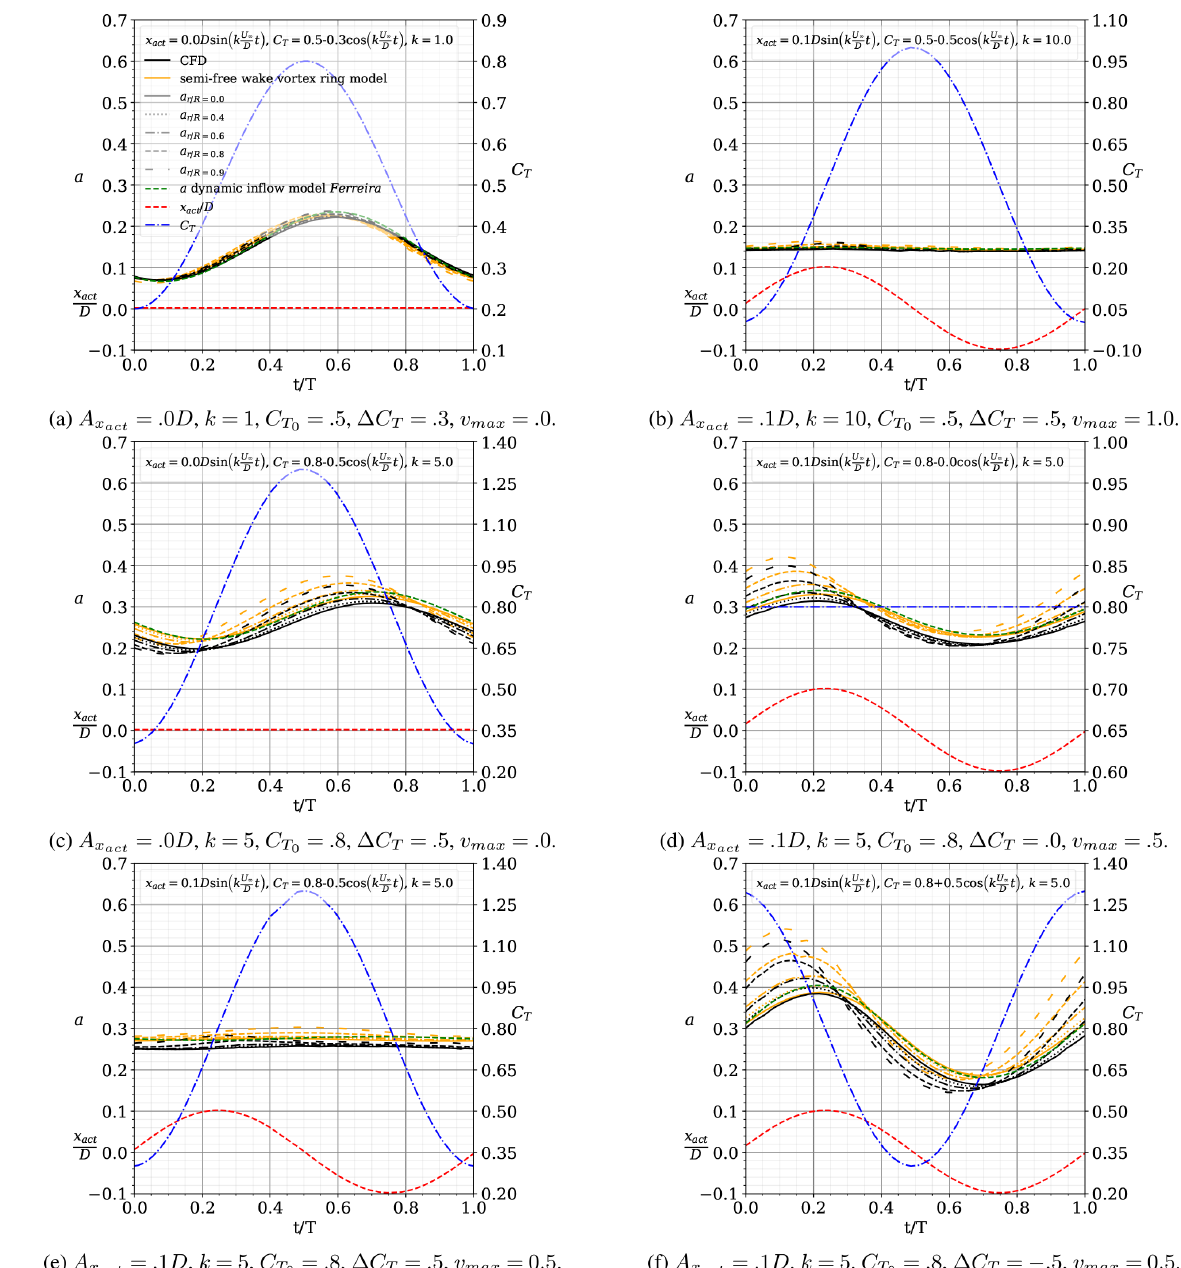
Figure 8. Comparison of the results of induction by CFD and the semi-free-wake vortex ring model at radial positions r/R = [ 0 . 0 ; 0 . 4 ; 0 . 6 ; 0 . 6 ; 0 . 9 ] and the proposed dynamic inflow model Ferreira for a sinusoidal surge motion with x act = A x − (cid:49)C T cos ( kU ∞ /Dt ) . The results are plotted over one period, along the non-dimensional time t/T with C T = C T 0